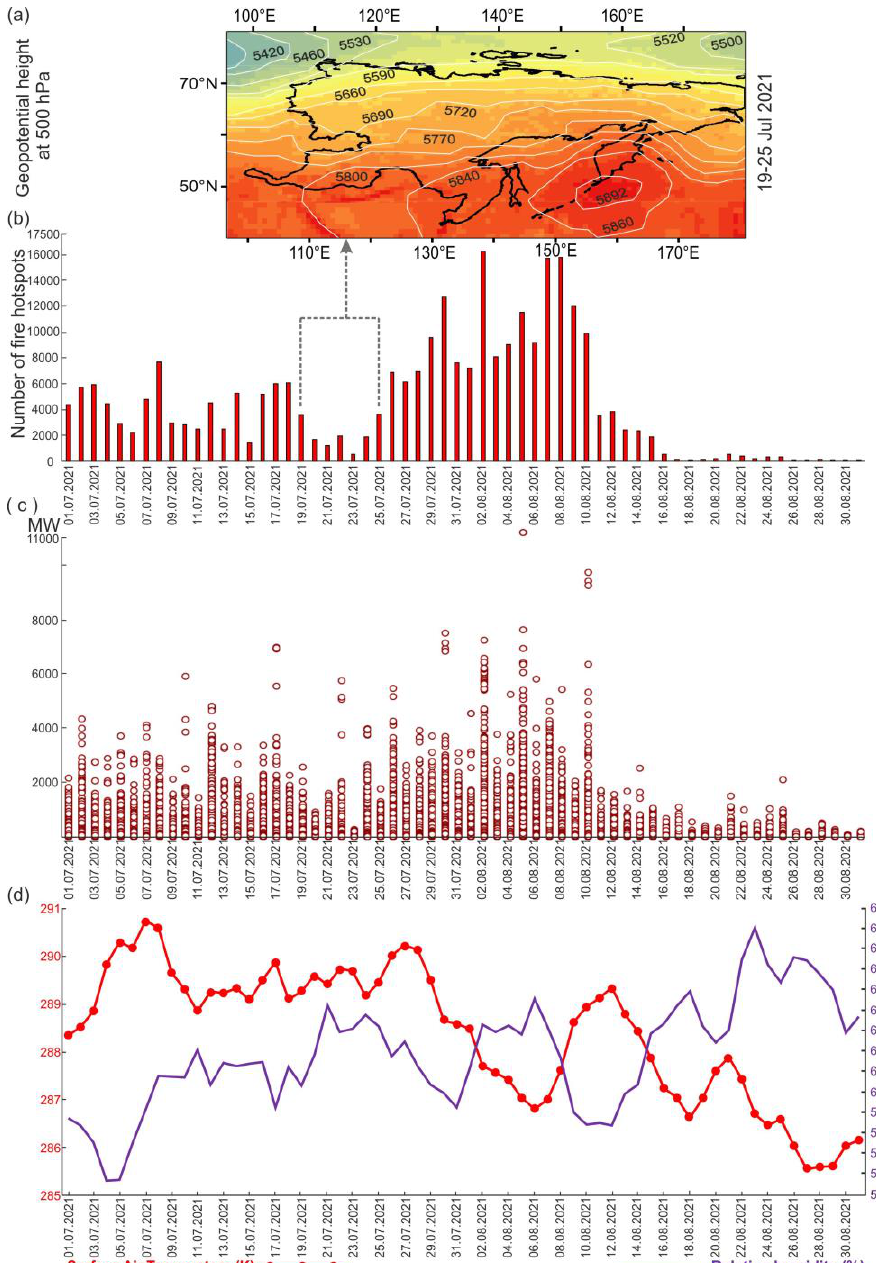
Figure 7. Changes in meteorological conditions and fire activity in the Far Eastern Federal District in July and August 2021: maps of geopotential height changes ( a ); distribution of the daily number of wildfire hotspots ( b ); distribution of daily FRP values ( c ); changes in the surface air temperature and relative humidity ( d ).